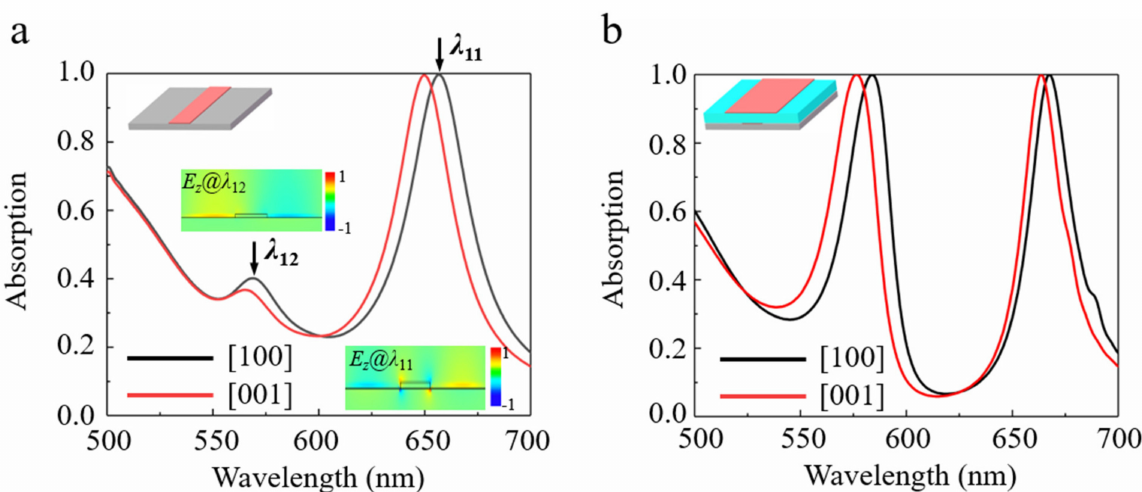
Figure 2. ( a ) Simulated absorption spectra of the α -MoO 3 nanoribbon stacked on Ag substrate, as polarized light along [100] (black curve) and [001] directions (red curve), respectively. ( b ) Simulated absorption spectra for the structure composed of Ag substrate/ α -MoO 3 nanoribbons/SiO 2 dielectric layer/ α -MoO 3 nanoribbons from bottom to top, as polarized along [100] (black curve) and [001] (red curve) directions, respectively. The optimized geometrical parameters are listed as follows: w 1 = 105 nm, w 2 = 275 nm, h = 100 nm, p = 500